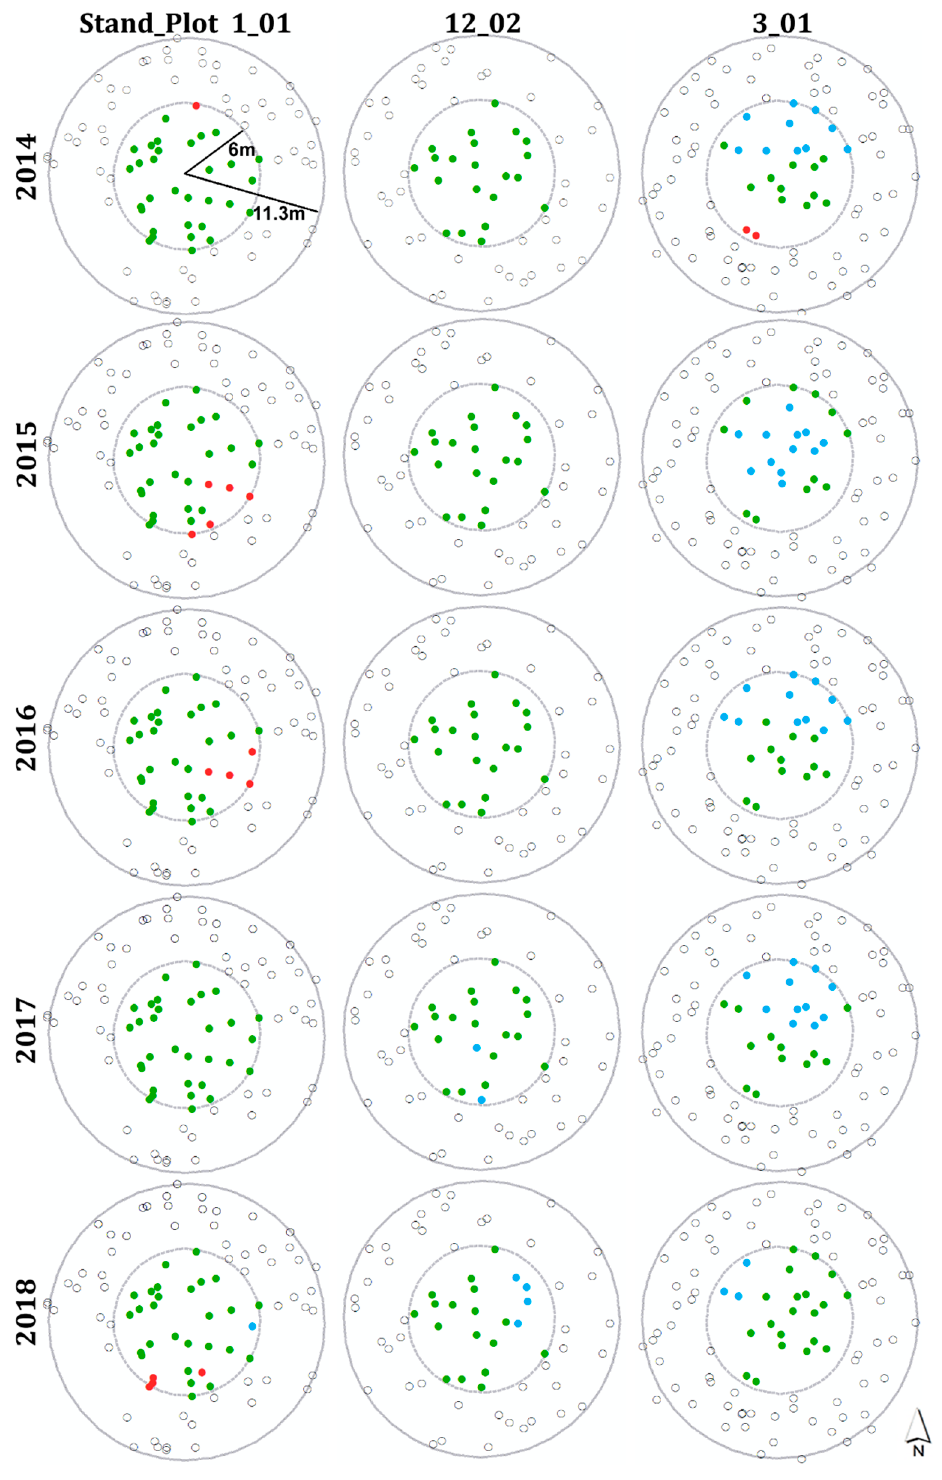
Figure 5. Stem maps of tree locations shown for the inner 6 m center of three example plots (same as in Figure 4) for five years, showing spatial distribution of hot spot trees, cold spot trees, and non-significant trees (based on results of Getis-Ord Gi* analyses; α = 0.05).